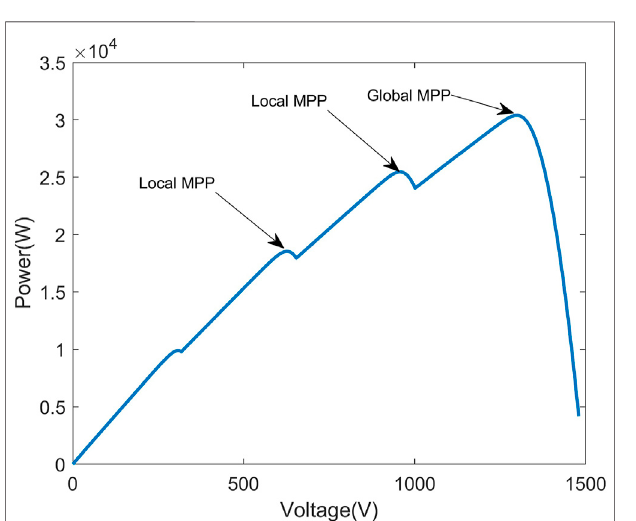
FIGURE 8 | Startup response of the fuzzy adaptive PSO and the convential PSO MPPT for irridiation 1.